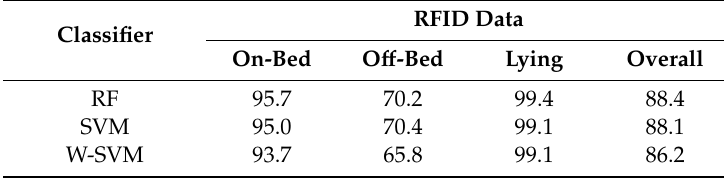
Table 6. Overall performance and performance by class using di ff erent classifiers on RFID dataset.